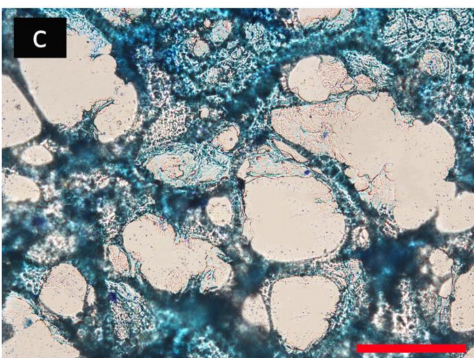
Figure 3. Optical images depict the micro-porosity of the hydrogels after 2 days ( a ), 5 days ( b ) and 10 days ( c ) of incubation in Ethylenediaminetetraacetic acid (2,2 (cid:48) ,2”,2 (cid:48)(cid:48)(cid:48) -(Ethane-1,2-diyldinitrilo) tetraacetic acid; EDTA) solution. Red arrows indicate alginate residuals. Scale bar: 100 micron.